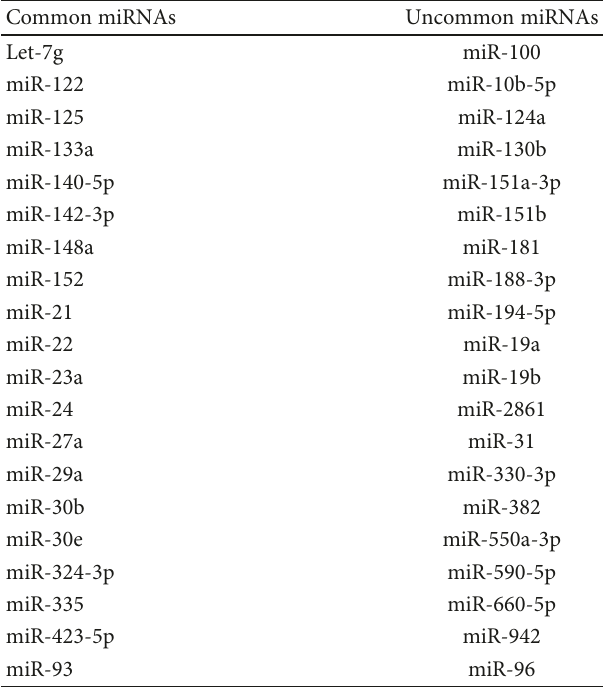
Table 1: Di ff erentially expressed miRNAs in osteoporotic patients that are commonly or uncommonly expressed in serum and plasma (miRBase V18.0